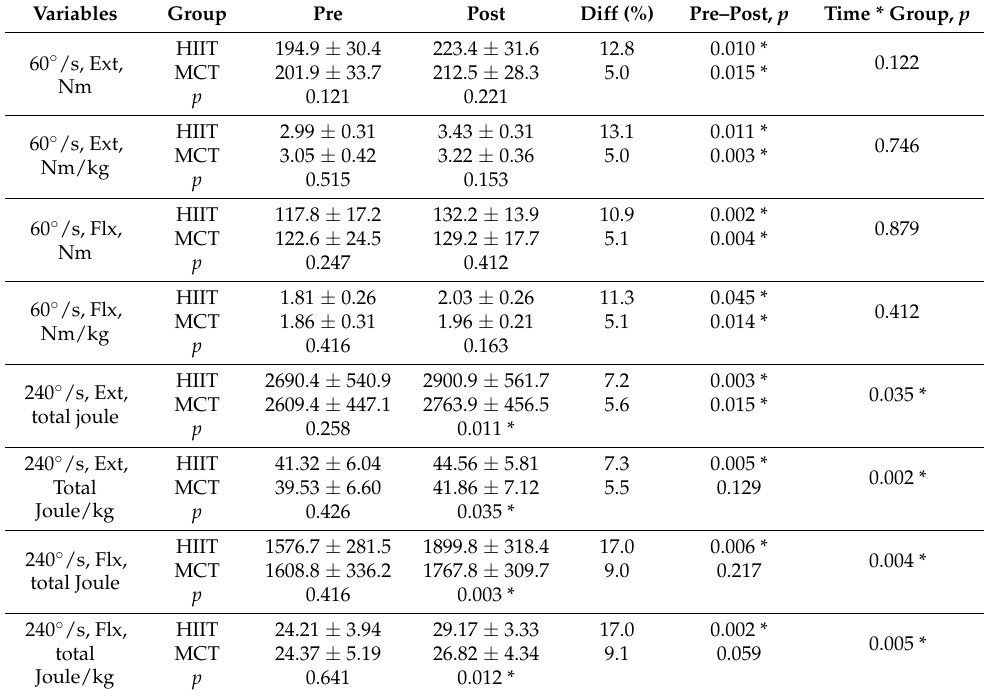
Table 7. Isokinetic strength